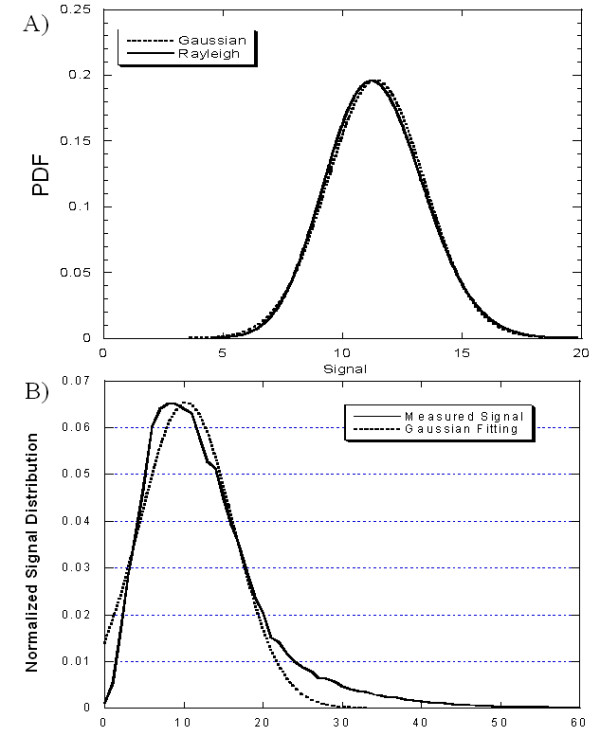
Statistical distribution of signal in normal myocardium. A) shape of the generalized Rayleigh PDF and of the Gaussian PDF for a background SD of 2.05 as measured in the present study in normal patients and for K = 8 phased array coils; B) measured distribution of the myocardial signal in normal patients as a normalized histogram and gaussian distribution.